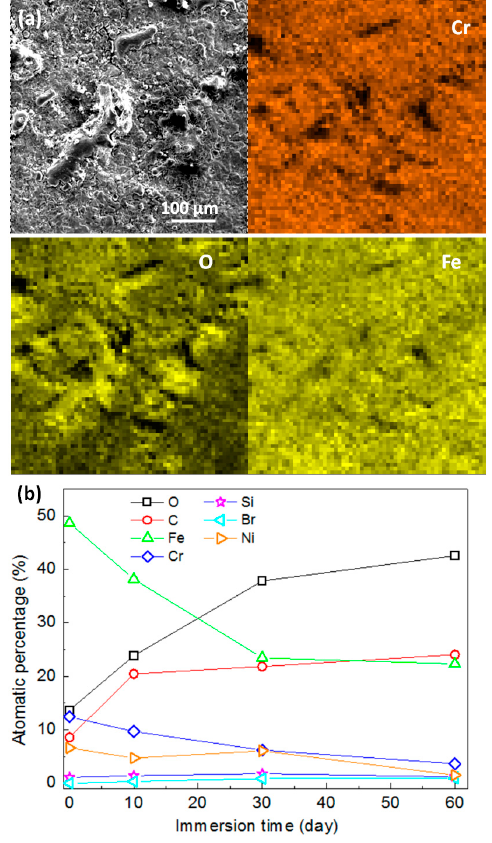
Figure 9. ( a ) EDS analysis of corroded 316L surface after 60 days’ immersion; ( b ) elementary composition of mechanically bonded 316L as a function of immersion time under high temperature and high pressure conditions.